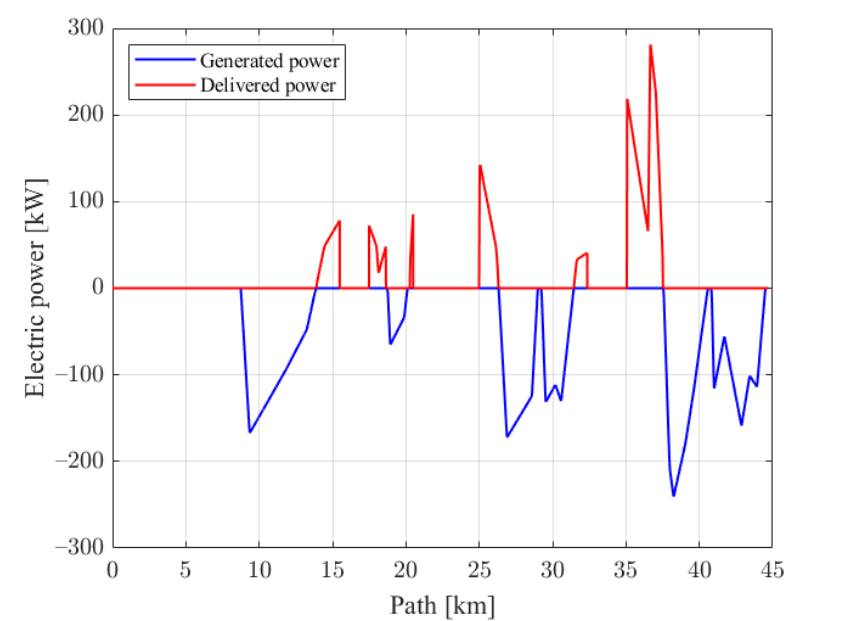
Figure 13. Power flow of the electric drive train over the entire